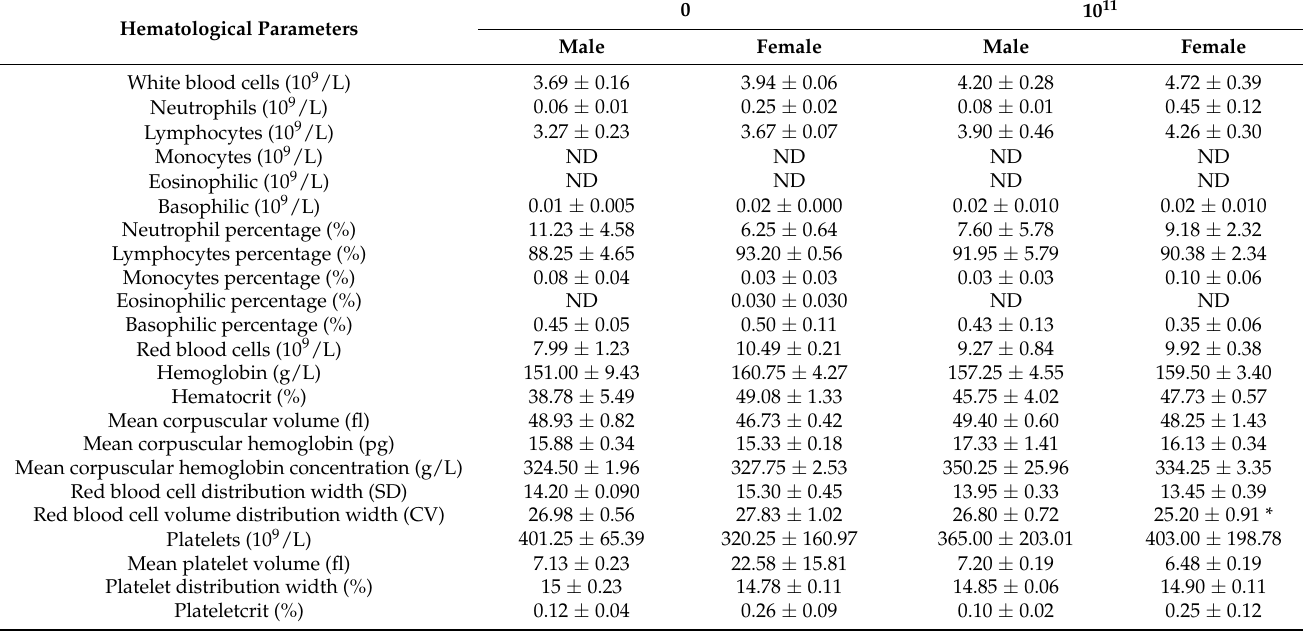
Table 3. Hematological parameters in mice for acute oral toxicity.